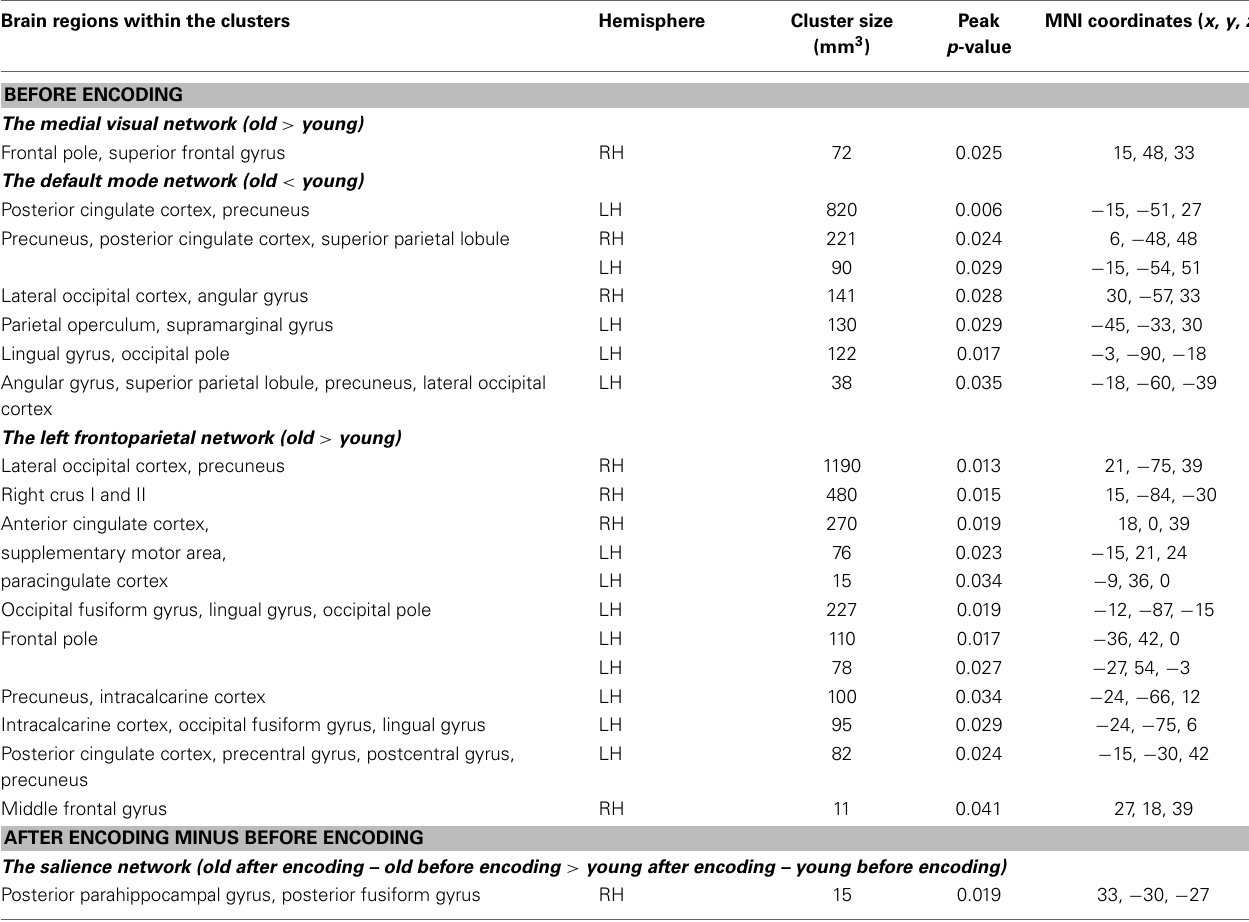
Table 3 | Group differences in resting-state connectivity of the networks of interest with the whole brain. Brain regions within the